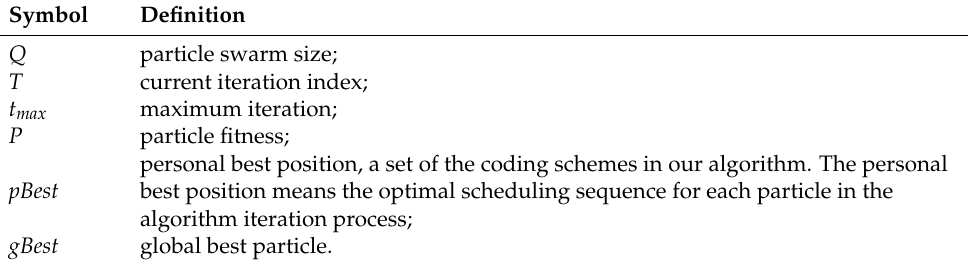
Table 3. The symbols used in the algorithm and their definitions.